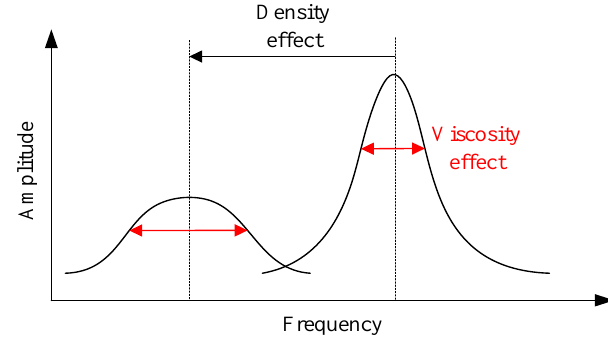
Figure 3. The density and viscosity effects under resonance.